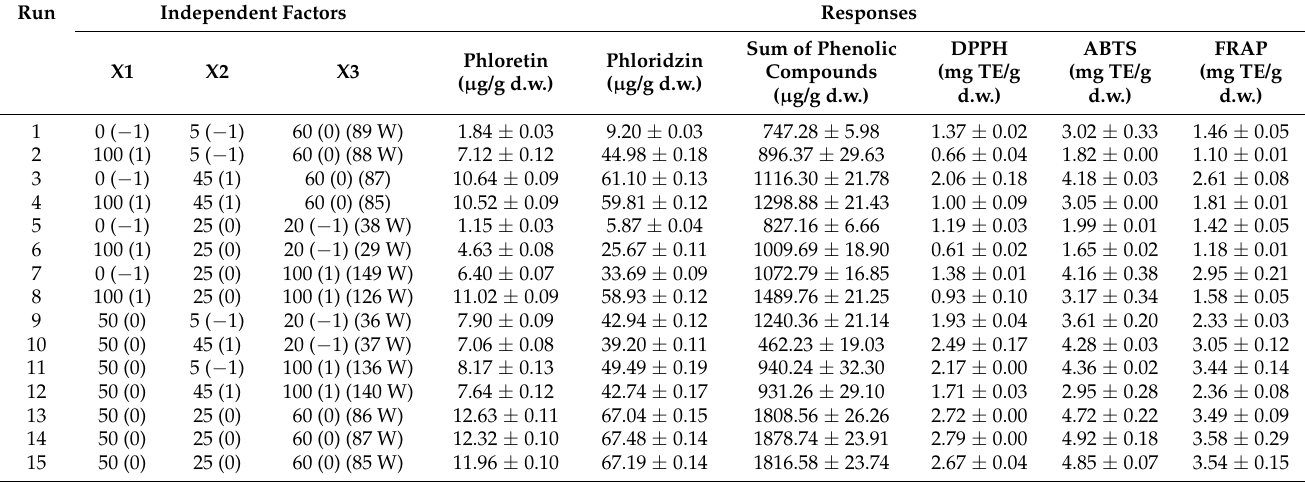
Table 2. Box–Behnken design with natural and coded values (parenthesis) of the conditions of extraction and the experimental results obtained for phloretin, phloridzin, the sum of phenolic compounds and antioxidant assays (DPPH, ABTS and FRAP) expressed as the average ± standard